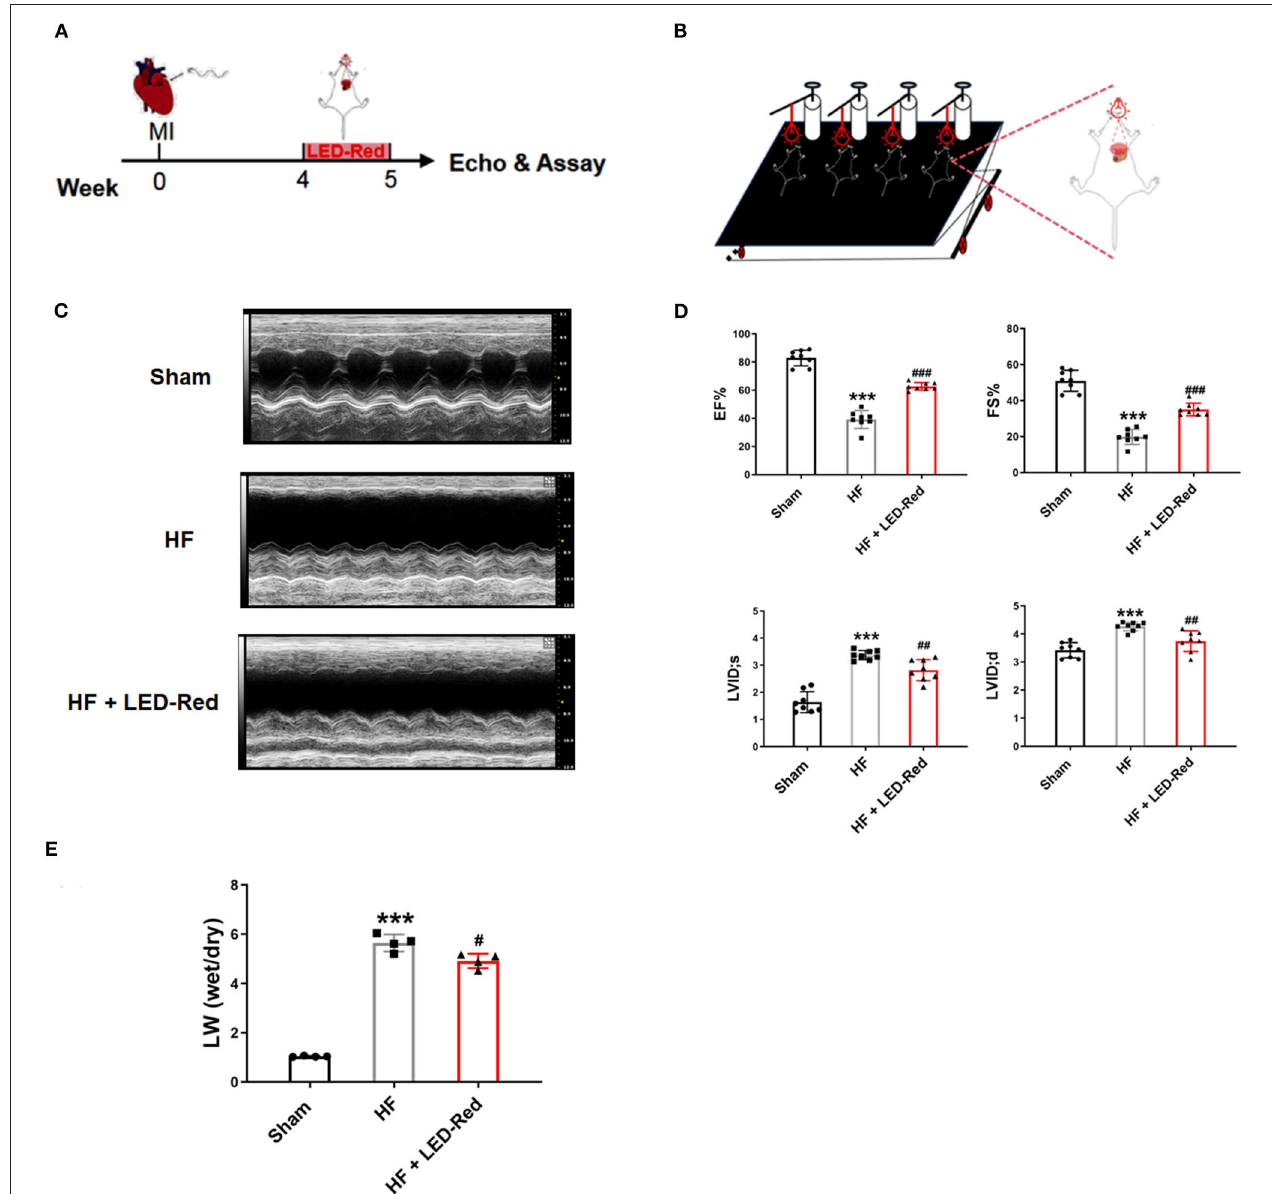
FIGURE 1 | LED-Red therapy improves heart function in mice with heart failure. (A) LED-Red therapy protocol. (B) Block diagram of the set-up of the LED-Red irradiation experiment. (C,D) Cardiac function by echocardiography. (C) Representative M-mode echocardiography of the left ventricle. (D) EF, Ejection fraction. FS, Fractional shortening; LVID; s, Left ventricular internal dimension end-systole; LVID; d, Left ventricular internal dimension end-diastole; n = 8. (E) Lung wet weight to dry weight ratio (LW-wet/LW-dry). n = 4. *** P < 0.001 vs. Sham, # P < 0.05 vs. HF, ## P < 0.01 vs. HF, ### P < 0.001 vs. HF. Data are expressed as the mean ±